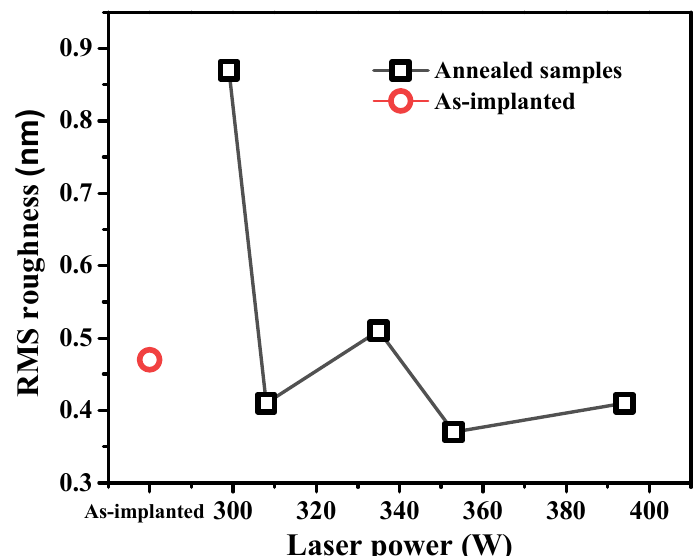
Figure 8. RMS roughness of the as-implanted and annealed samples.